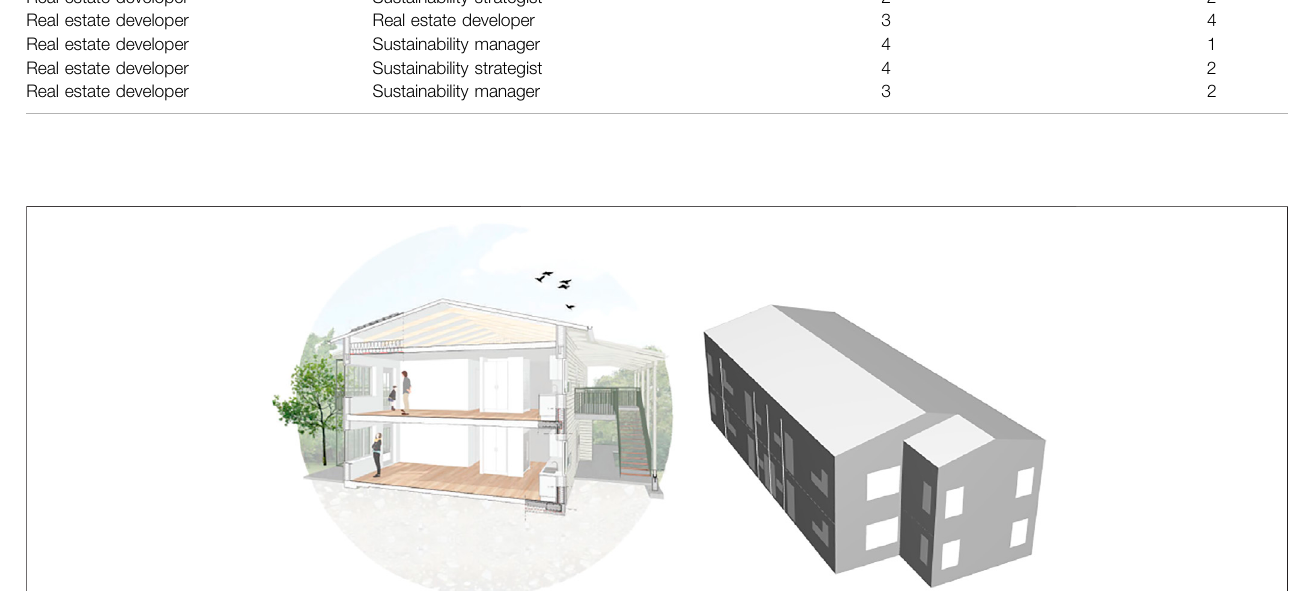
FIGURE 2 | The case study building 8